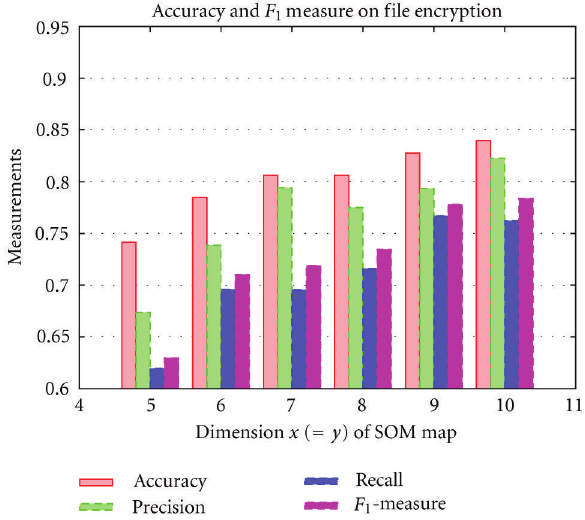
Figure 17: Performance on Information Encryption by SOMs.